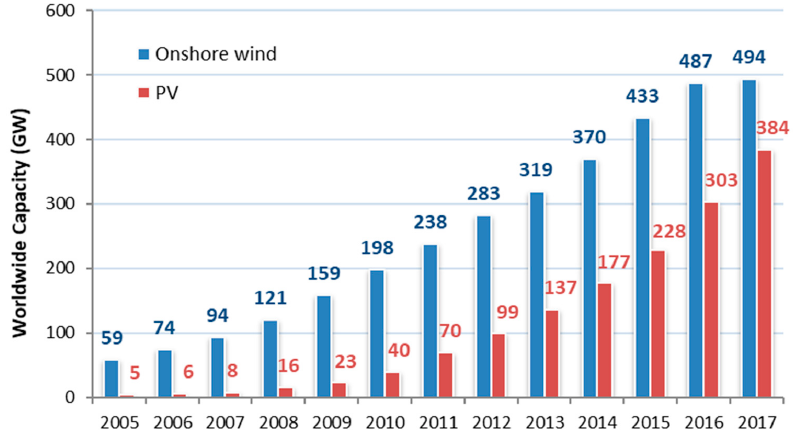
Figure 1. Wind and photovoltaic (PV) installed power worldwide. Source: [7,8].